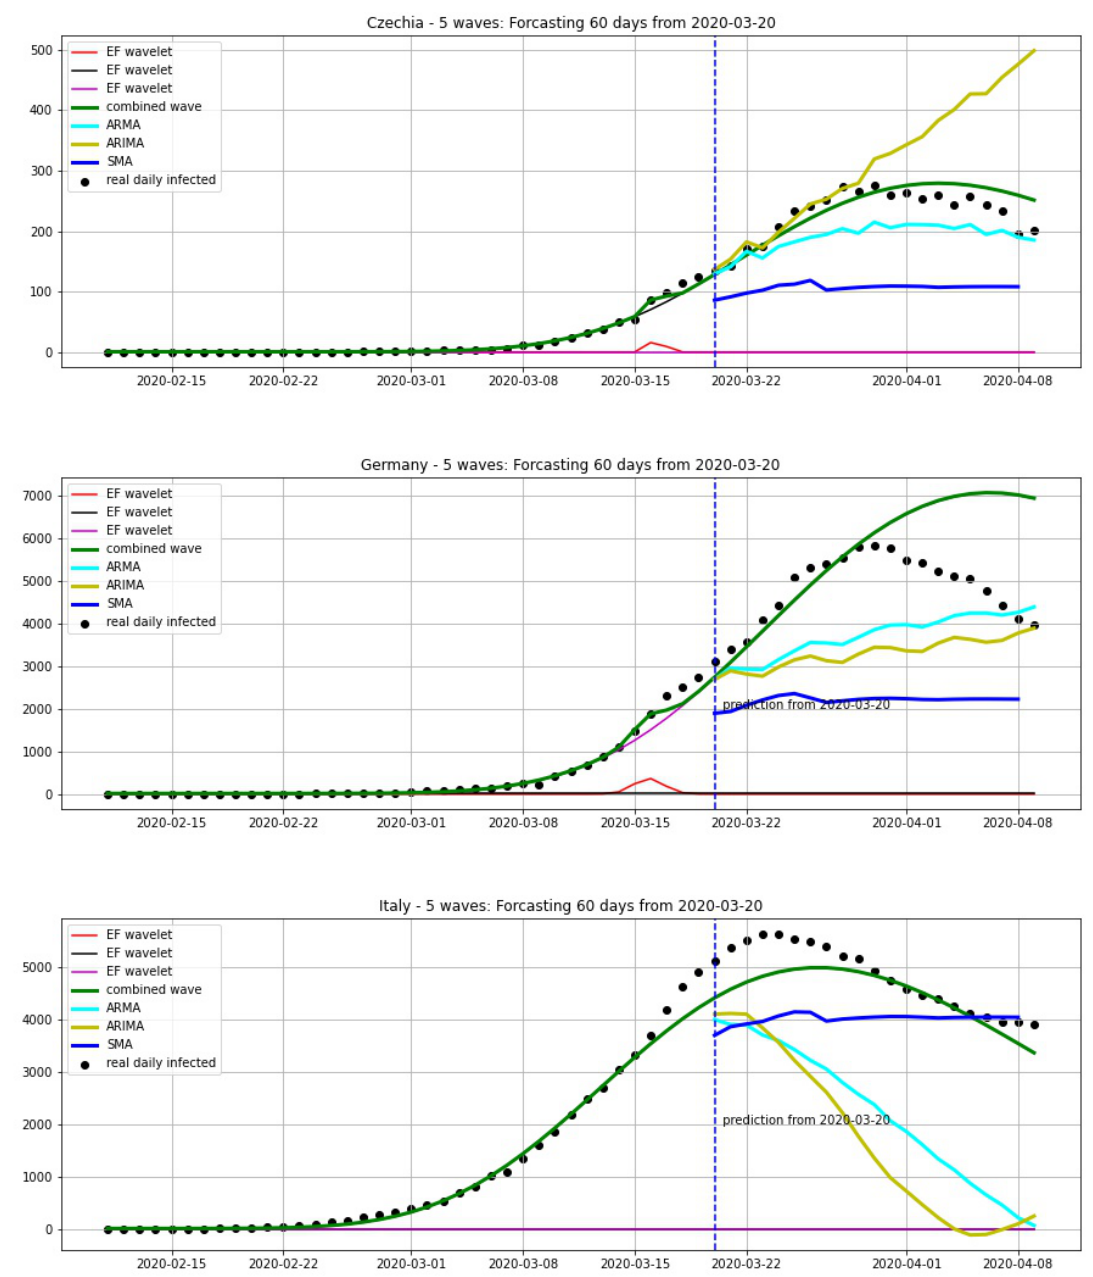
Figure 20. Forecasting 20 days from 30 March, using a wavelet model (green curve) which is combined by EF wavelets, SMA (blue curve), ARMA model (cyan curve) and ARIMA model (yellow curve)